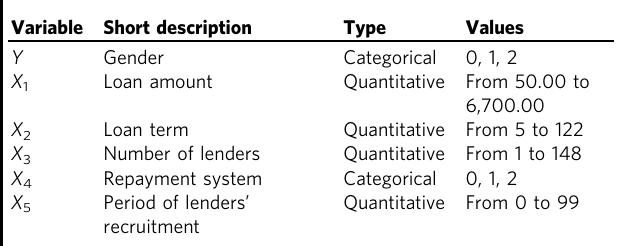
Table 4 Type of variables involved in the analysis. Source: Own